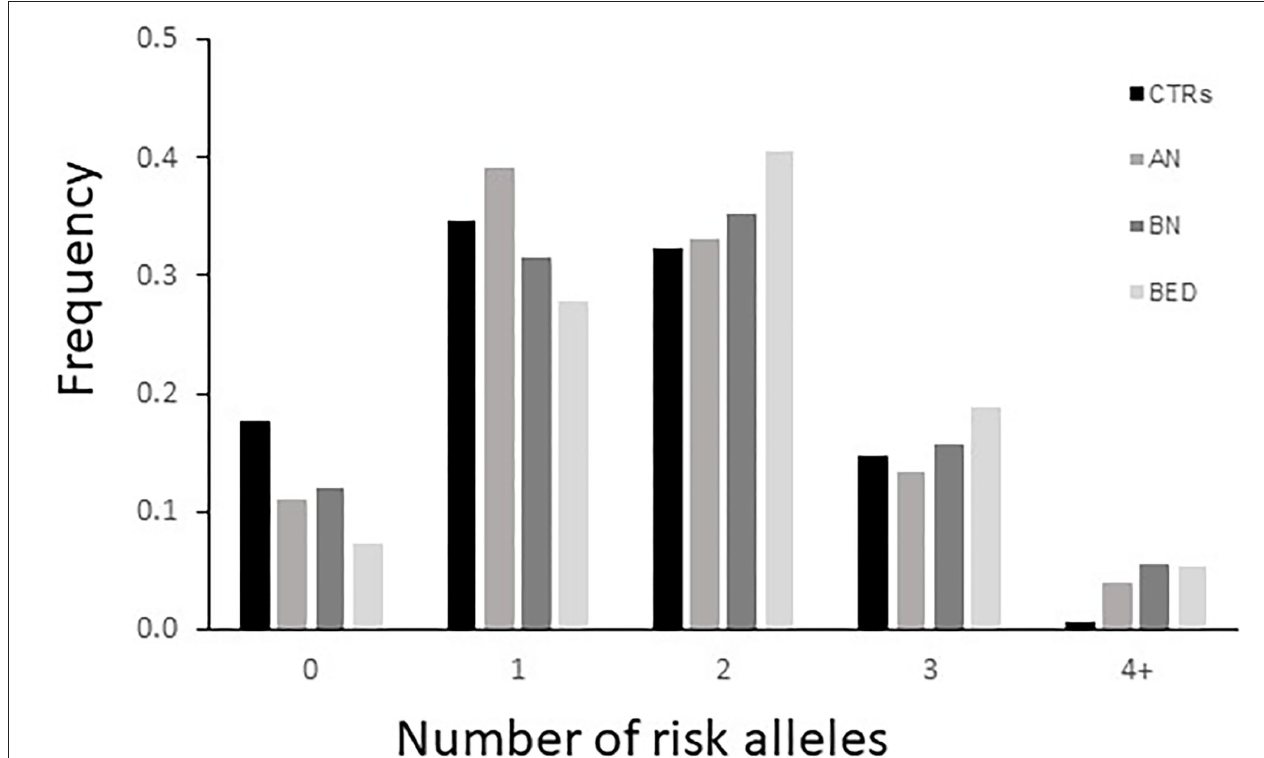
FIGURE 1 | Distribution of DRD2 and DRD4 risk alleles risk in cases [patients with anorexia nervosa (AN), bulimia nervosa (BN), and binge eating disorder (BED)] and healthy controls (CTRs). The variant allele of DRD2 -rs6277, ≥ 7 repeats of the DRD4 - 48bp variable number tandem repeat (VNTR), and S allele of DRD4 -120bp TR were included as risk